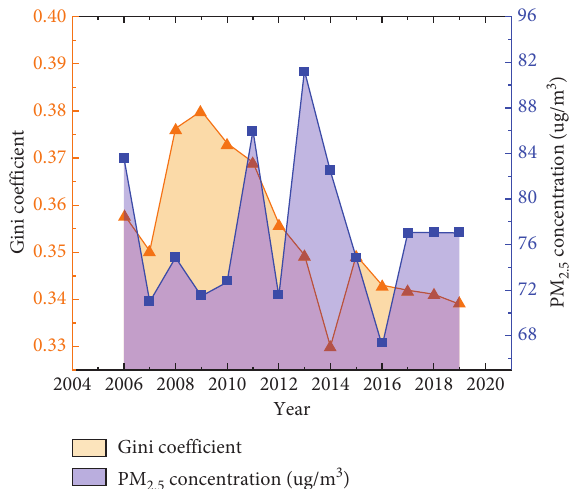
Figure 9: The Gini coefficient and the PM Hebei.